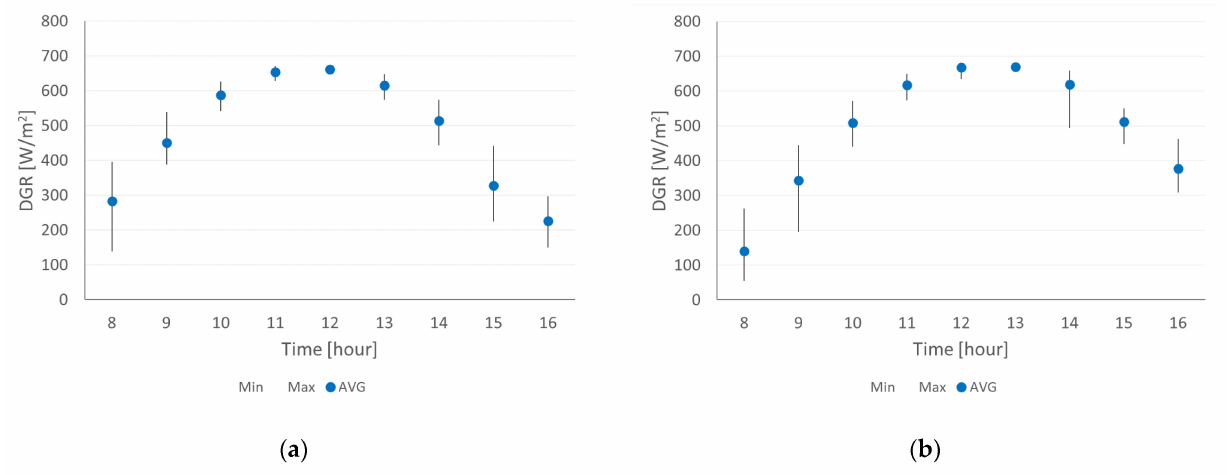
(cid:17) (cid:16) (cid:104) t (cid:105) h , i (cid:17) (cid:16) (cid:104) t (cid:105) , the h , i (cid:17) (cid:16) (cid:104) t (cid:105) and the maximum , min h , i ≡ (cid:10) t − 0.5; t + 0.5 (cid:11) for h , i h , i h , i